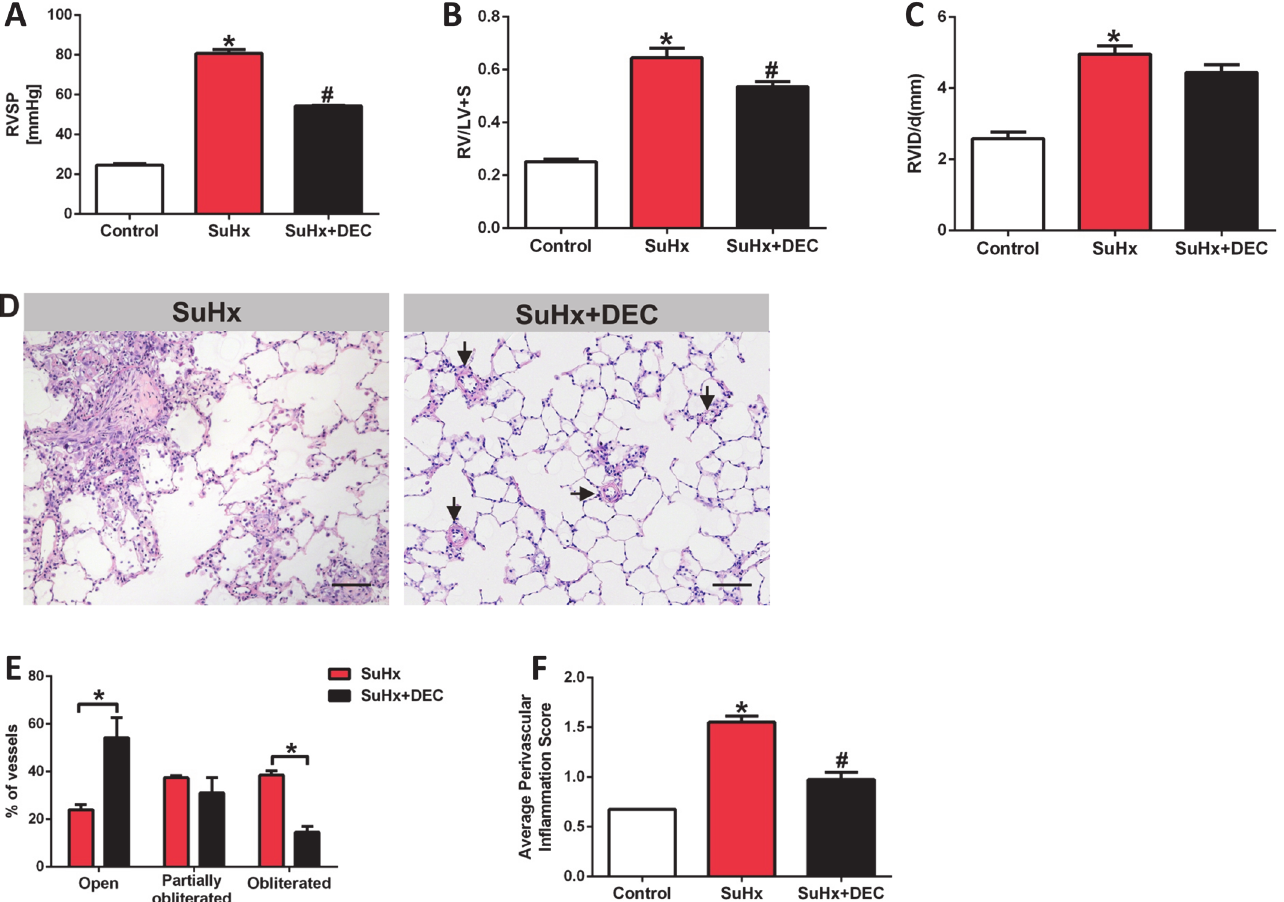
Fig 8. Diethylcarbamazine treatment of animals with established lung vascular disease (intervention trial). (A) Right ventricular systolic pressure (RVSP) in animals subjected to the SuHx protocol (SuHx) (n = 6) and animals treated with diethylcarbamazine (DEC) after pulmonary hypertension had been established (n = 5). There is a treatment related reduction in the RVSP. (B) There is a reduction in the DEC-treated animals ’ RV hypertrophy and (C) (n = 6). There is no significant reduction in the right ventricular internal diastolic diameter (RVID/d) (n = 6). (D) Shows representative sections from SuHx rat ’ s lung treated with a daily dose of 50 mg/kg DEC for 2 weeks, scale bar = 100 μ m. (E) Shows that the percentage of open vessels are greater and that there are fewer obliterated vessels after DEC treatment (n = 6). (F) Shows a reduction in the average of perivascular inflammation after treatment with DEC (n = 6). * P < 0.05 vs. control, #P < 0.05 vs.